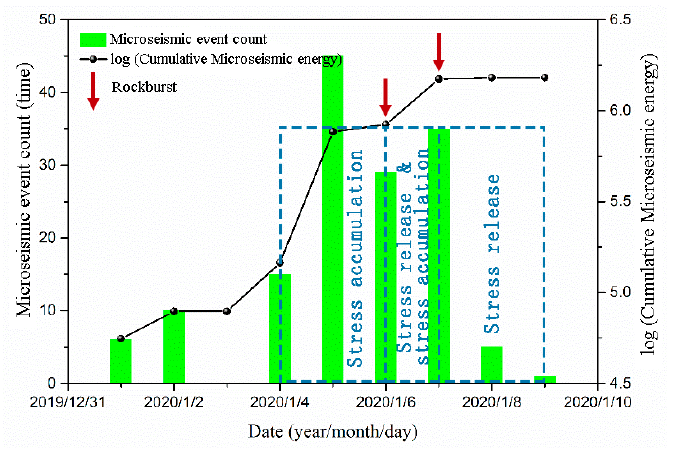
Figure 8. Evolution process of the microseismicities in theLingbei TBM construction section.